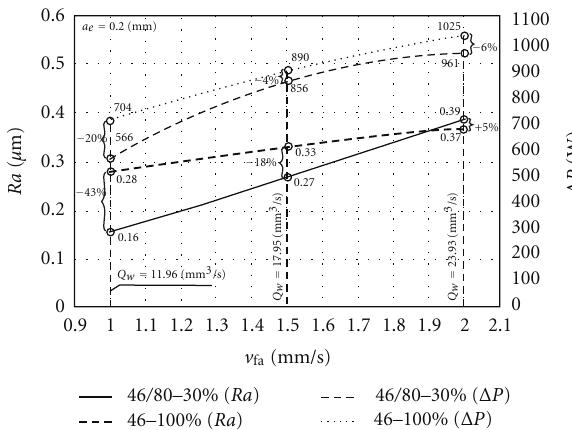
Figure 7: Comparison of changes in the arithmetic mean roughness Ra and grinding power gain Δ P measured after grinding using 46/80–30% and 46–100% grinding wheels as a functionof the feed speed v fa at the working engagement a e = 0 . 20